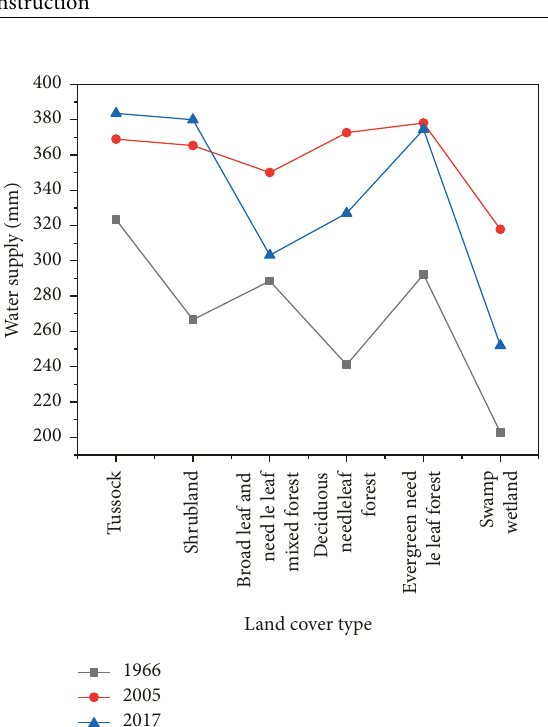
Figure 4: Total water supply of each land cover